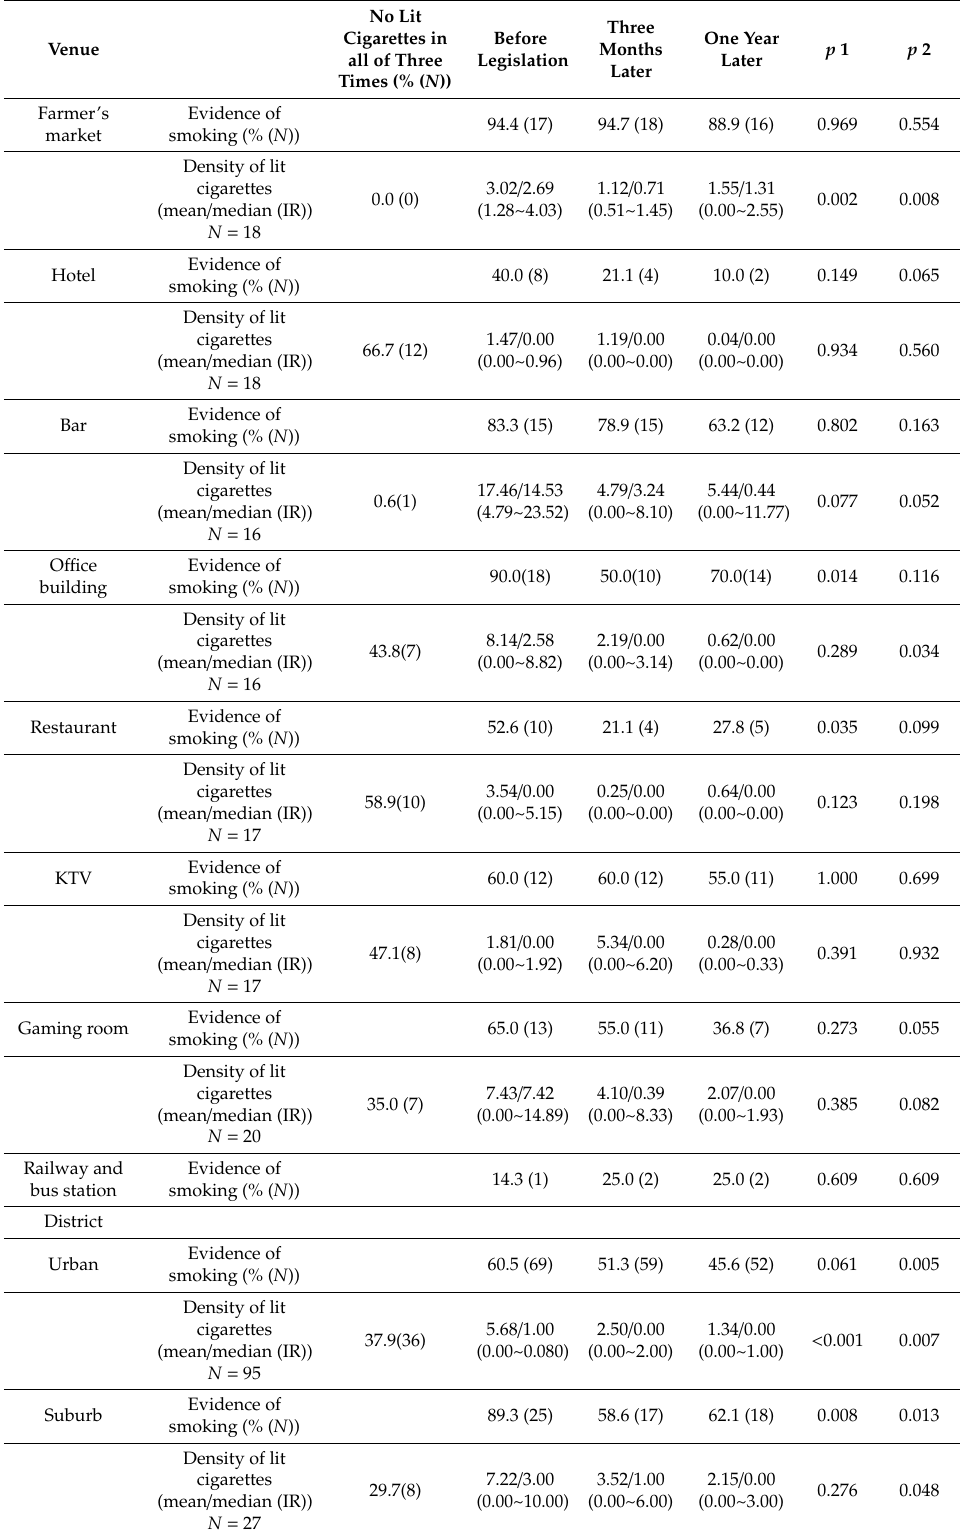
No Lit Three One Year Cigarettes in Before p 1 p 2 Months Legislation Later all of Three Later Times (% ( N ))